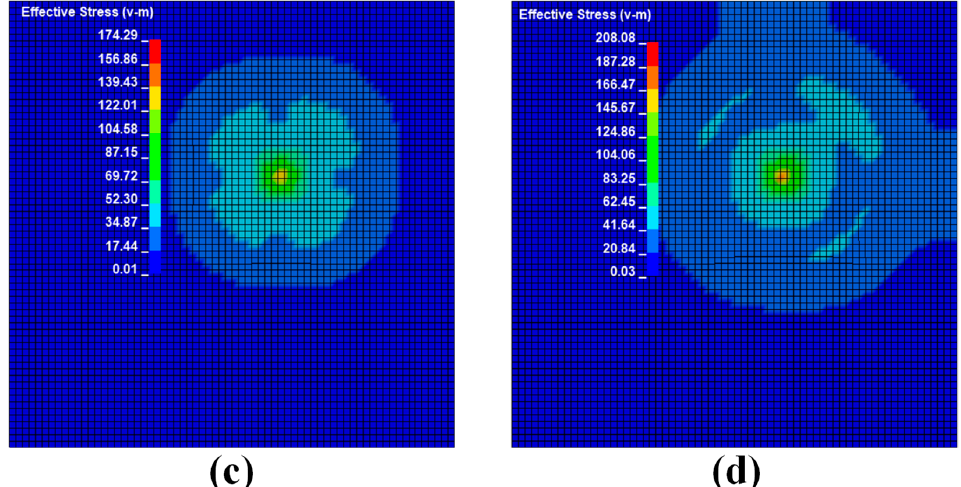
Figure 9. Stress cloud diagram of impact response at different velocities at position 2: ( a ) shock response stress cloud diagram at an impact speed of 1 m/s; ( b ) shock response stress cloud diagram at an impact speed of 1.5 m/s; ( c ) shock response stress cloud diagram at an impact speed of 2 m/s; ( d ) shock response stress cloud diagram at an impact speed of 2.5 m/s.